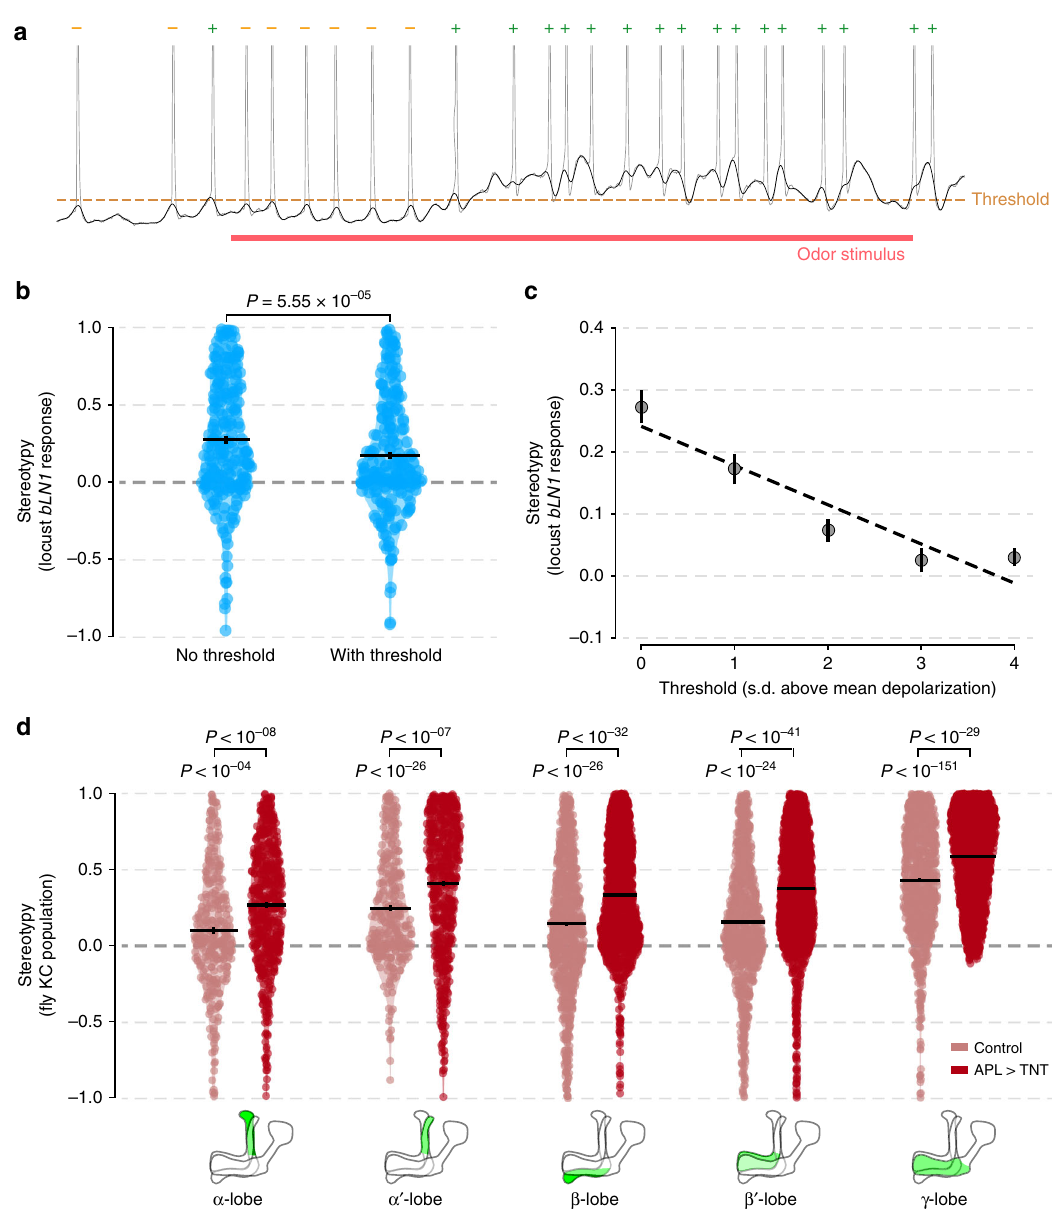
Fig. 7 Experimental data con fi rm the antagonism between sparseness and stereotypy. a A representative intracellular recording (gray) from locust bLN1 is shown to illustrate the method of removing spikes that occur at depolarizations below a threshold (dashed line). Discarded spikes are labeled ‘ − ’ and retained spikes are labeled ‘ + ’ . The depolarization (dark black trace) is extracted by clipping spikes and fi ltering the recording (50-Hz low-pass). The threshold is set at one s.d. above the mean depolarization. b Stereotypy in locust bLN1 response reduces when we mimic more sparseness by removing spikes below the threshold (1 s.d. above mean depolarization). c Stereotypy continues to reduce as sparseness is further increased by raising the threshold in multiples of s.d. above mean depolarization. In b , c , n = 225 values (15 pairs of odors × 15 pairs of individuals). d Fly KC populations imaged at different lobes of the mushroom body in control fl ies reveal signi fi cant stereotypy. The stereotypy further increases in all lobes as sparseness is reduced by blocking APL output (APL>TNT); n = 315 (control, α - and α ′ -lobes, from 11 hemispheres from 10 fl ies), n = 570 (APL>TNT, α - and α ′ -lobes, from 20 hemispheres from 14 fl ies), n = 828 (control, β -, β ′ - and γ -lobes, from 18 hemispheres from 15 fl ies), n = 1890 (APL>TNT, β -, β ′ - and γ -lobes, from 36 hemispheres from 24 fl ies). Error bars represent